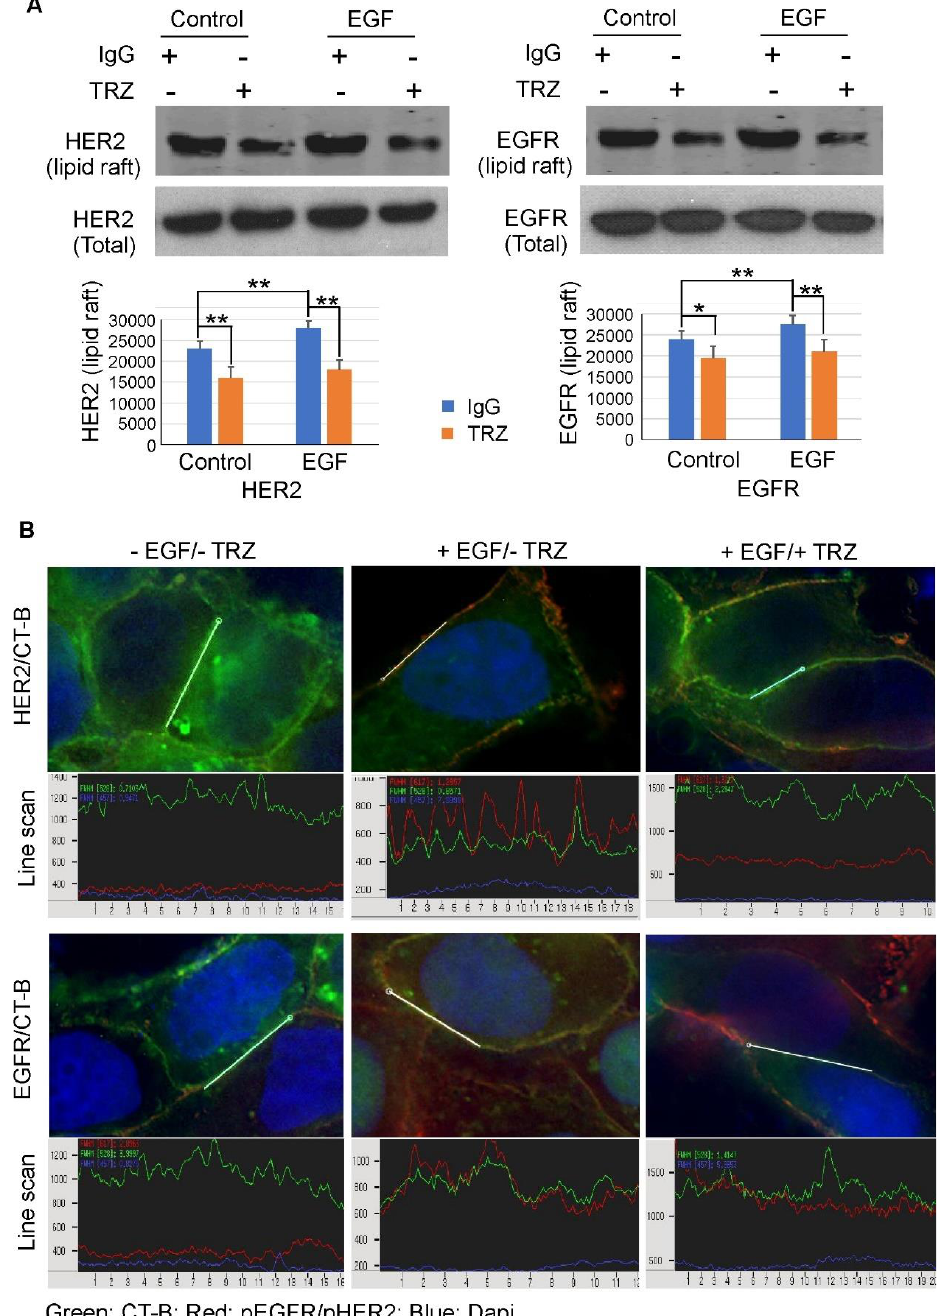
Figure 8. The effect of trastuzumab on EGF-induced lipid raft localization of EGFR–HER2 heterodimer in BT474 cells. ( A ) EGFR and HER2 level in isolated lipid rafts. The cells were incubated with trastuzumab or normal human IgG (10 µ g/mL) for 1 h and then stimulated with EGF (50 ng/mL) for 30 min. Proteins associated with lipid rafts were isolated by using Bio-Rad ReadyPrep™ Protein Extraction Kit (Signal). The level of HER2 and EGFR receptors in isolated lipid rafts were examined by immunoblotting. Each value is the average of three experiments and the error bar is the standard error. *: p < 0.05, **: p < 0.01. ( B ) Co-localization (yellow) of pEGFR (red) and pHER2 (red) with Alex Fluor 488 conjugated CT-B (green). Cells were incubated with CB-T (10 µ g/mL) with or without trastuzumab (10 µ g/mL) for 1 h and then stimulated with EGF for 30 min. The localization of EGFR or HER2 was revealed by TRITC conjugated secondary antibody following the incubation with the primary antibody. Nucleus was counter stained with